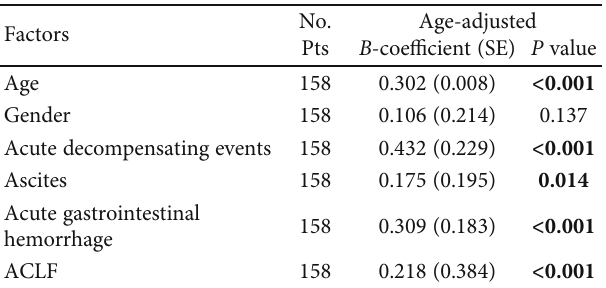
Table 4: Multivariate linear regression analysis of factors associated with the NT-pro BNP